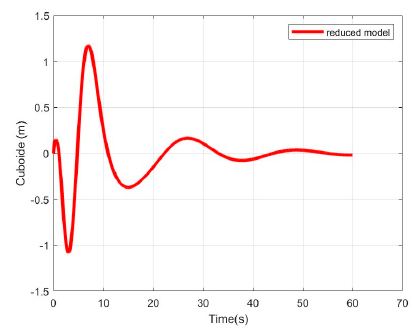
Figure 12. Position of the cuboid.